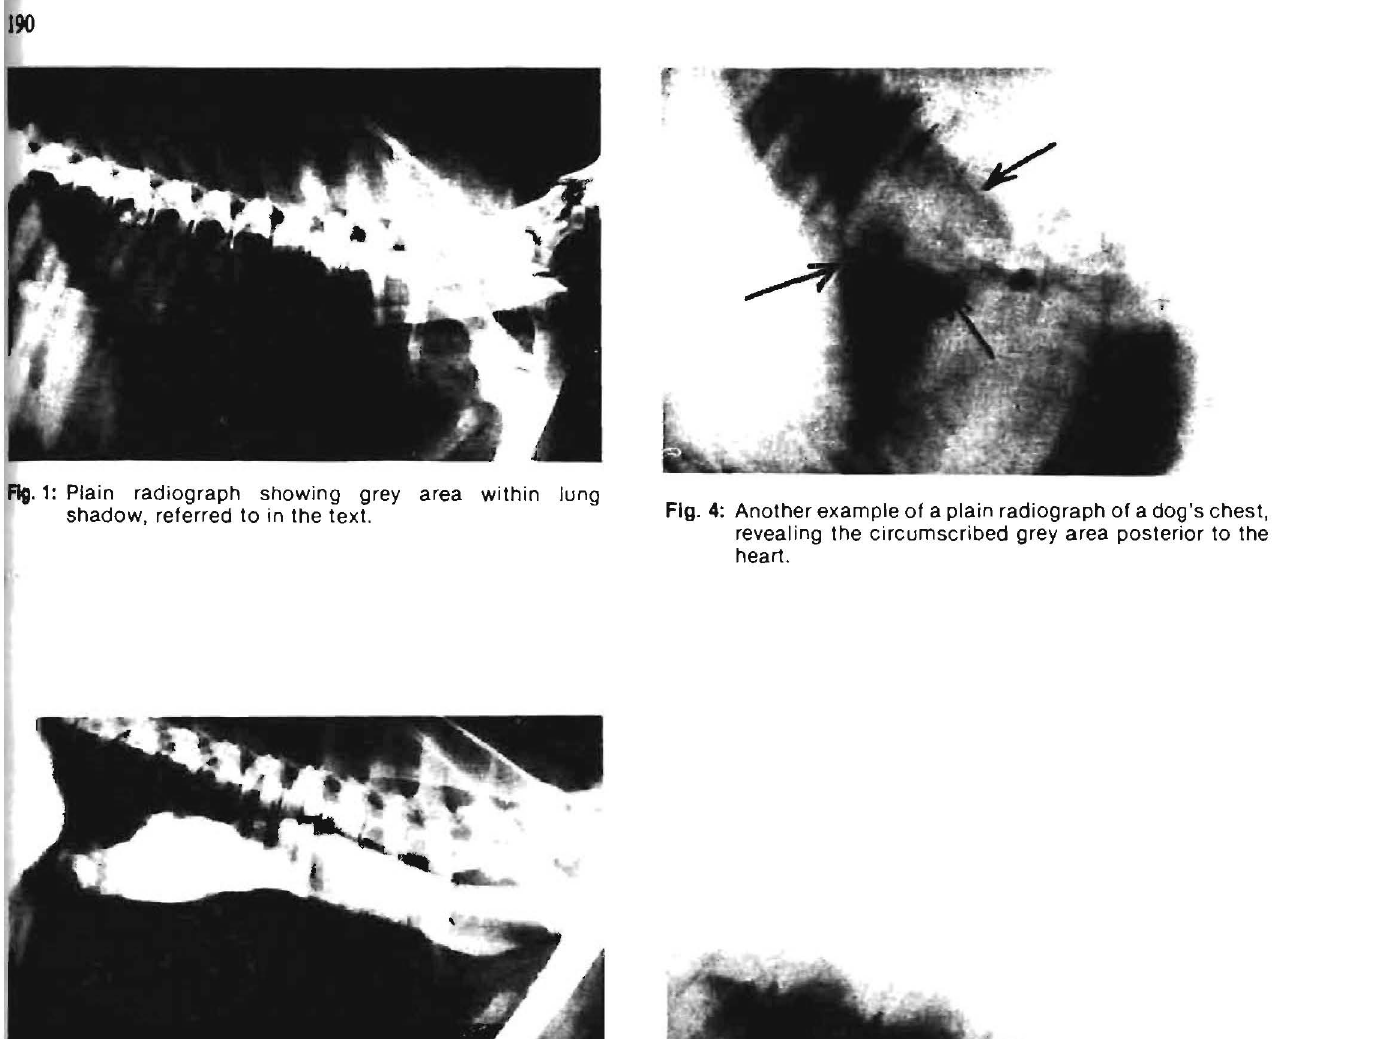
fig. 2: Barium filled oesophagus, showing the oesophageal dilatation resulting from the obstruction within the oesophagus.